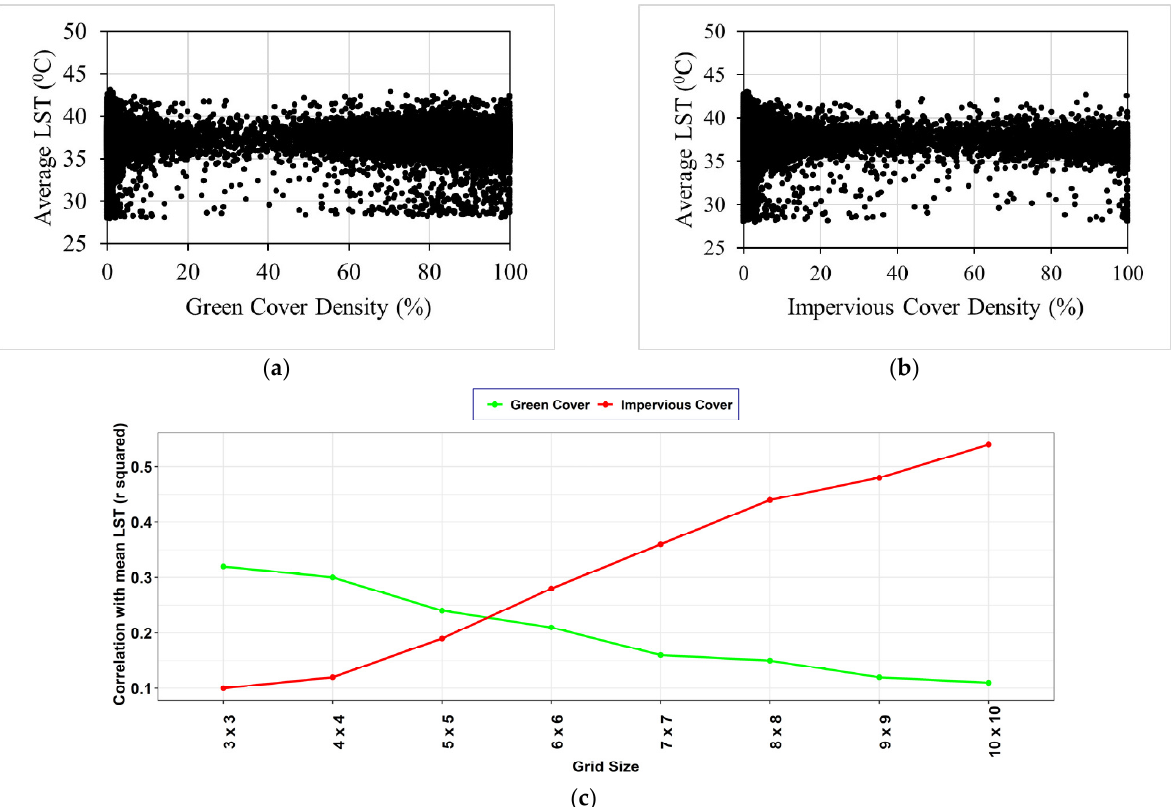
Figure 6. Scatter plots between average land surface temperature (LST) and ( a ) green cover density and ( b ) impervious cover density. ( c ) Variation in correlation of average LST and impervious and green cover density against variation in